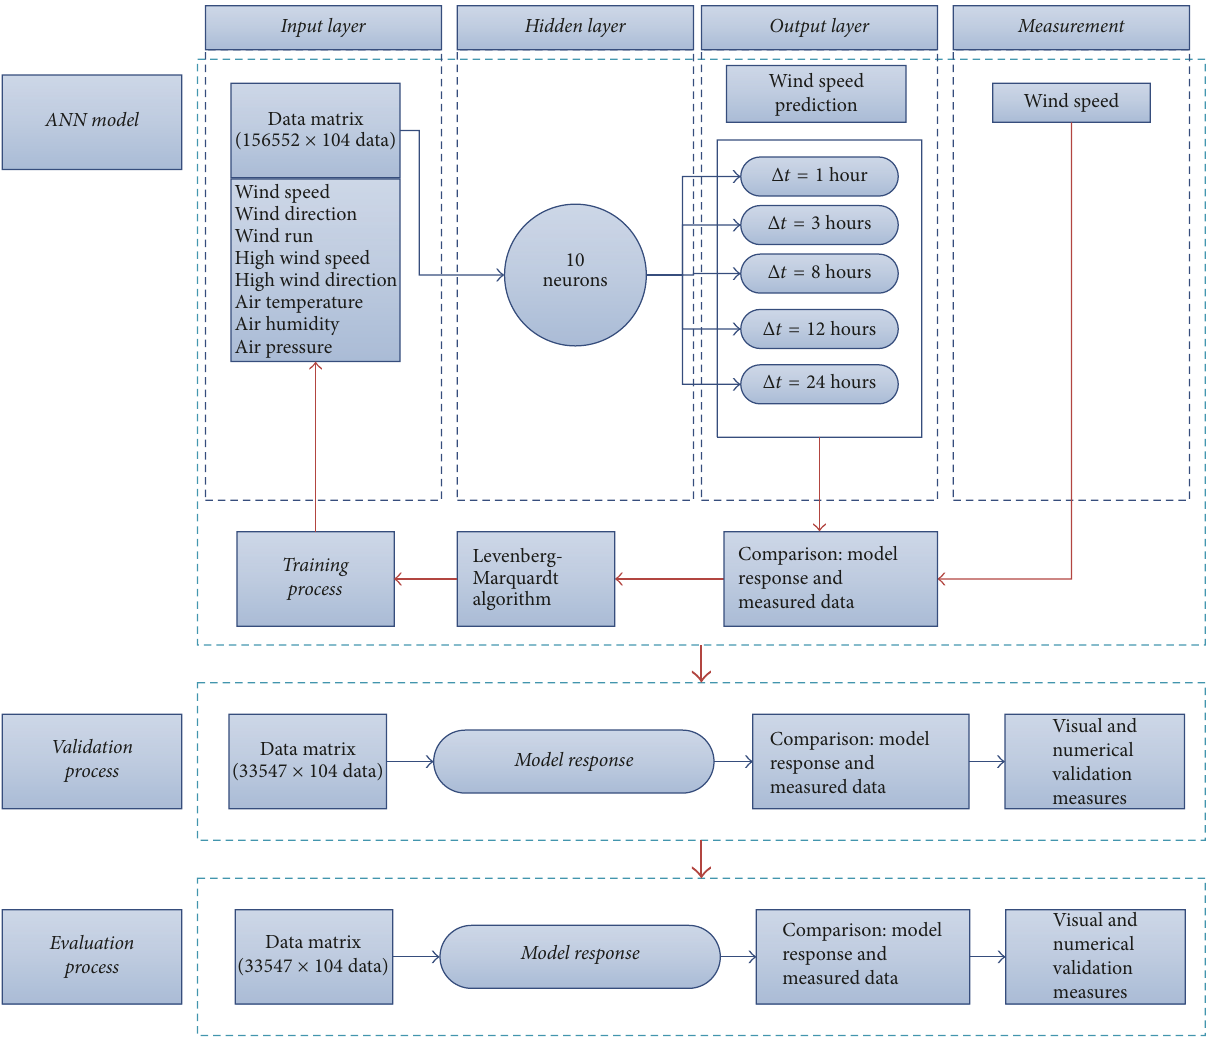
Figure 6: Schematic representation of the ANN wind speed prediction model based on [14, 15].